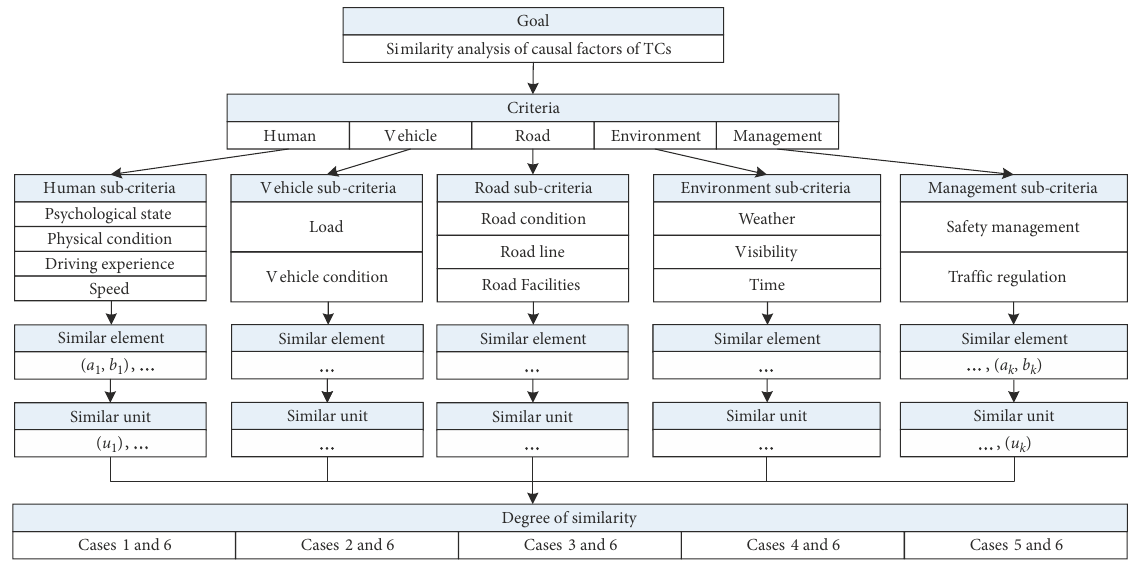
Figure 5. Hierarchical structure of the AHP-S model used for the similarity analysis of the causal factors of TCs Table 7. Causal factors of six TC